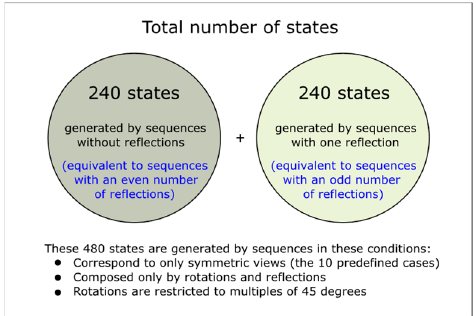
Figure 9. Total number of states due to rotations and reflections.